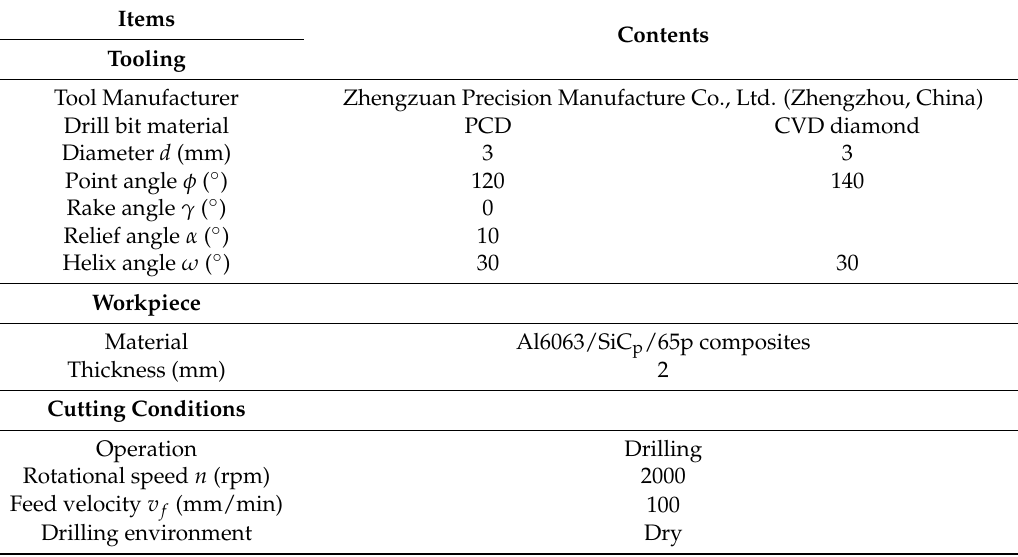
Table 2. Summary of experiment details.